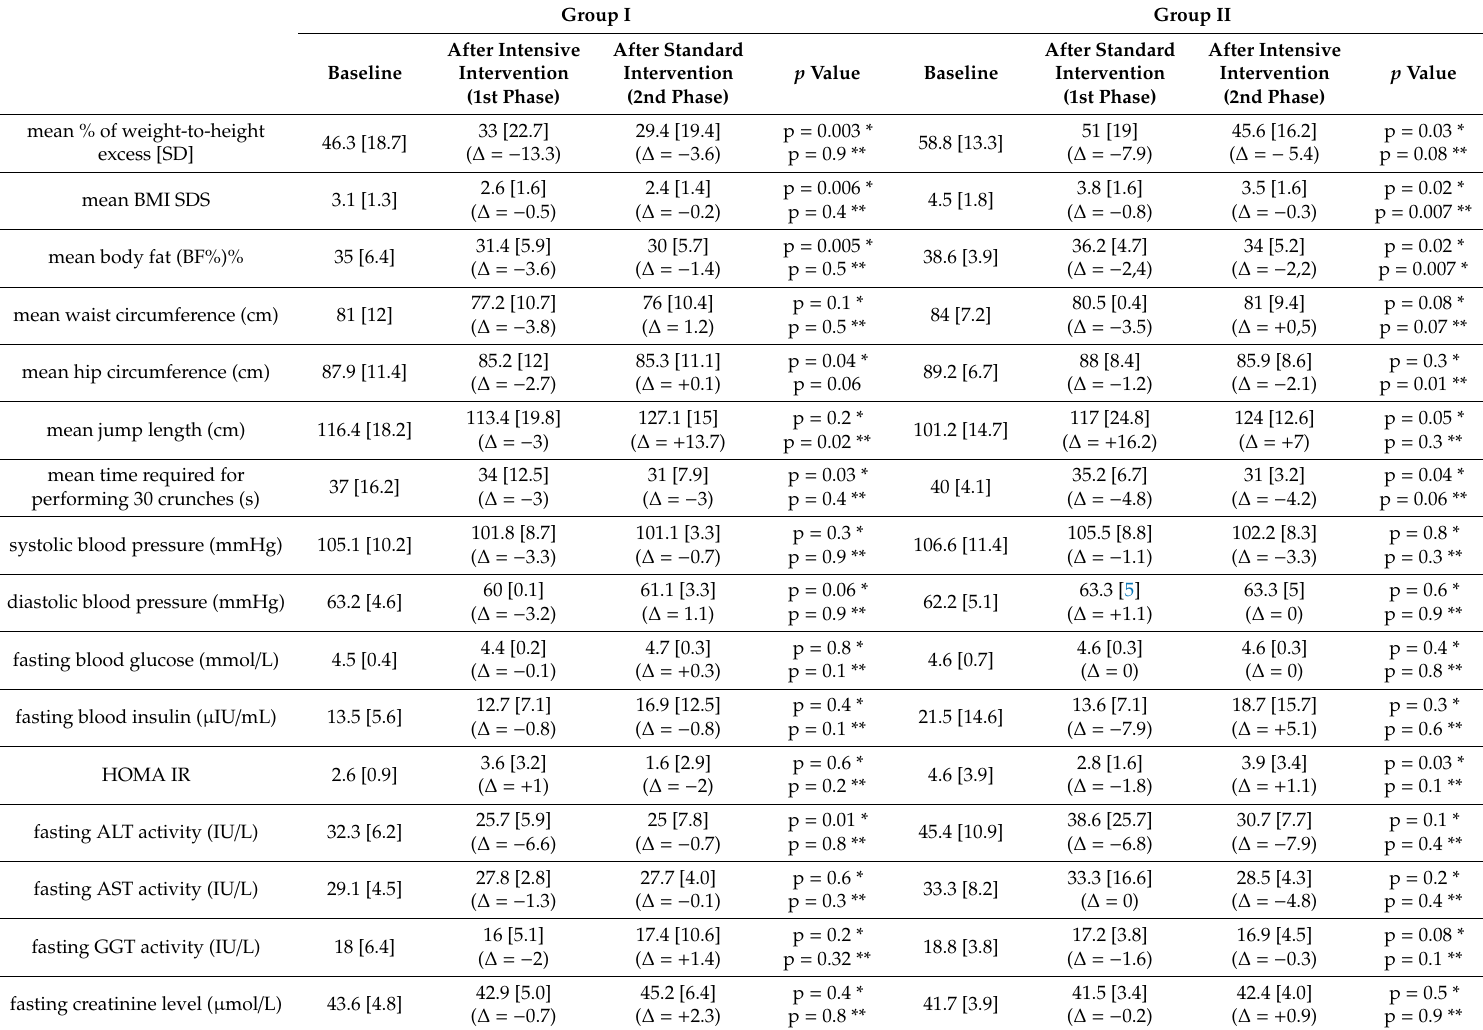
Table 2. Comparison of the results of each phase of intervention (intensive and standard) in both